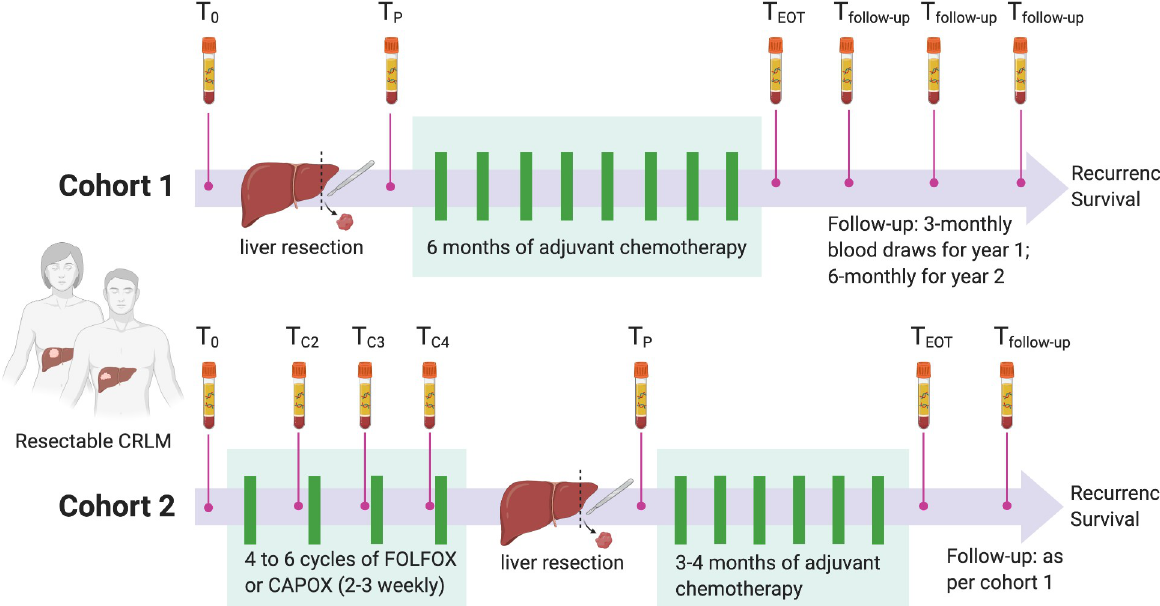
Fig 1. Study design. Study schema showing blood collection time points in Cohort 1 (upfront liver resection) and Cohort 2 (neoadjuvant chemotherapy). The primary objective of the study was to assess the prognostic impact of postoperative ctDNA (T P ) on recurrence-free survival in the total population. T 0 = baseline, T C2 = pre-cycle 2, T C3 = pre-cycle 3, T C4 = pre-cycle 4, T P = 4 to 10 weeks postoperative, T EOT = end of treatment, T follow-up = follow-up. CRLM AU : AbbreviationlistshavebeencompiledforthoseusedinFigs 1 (cid:0) 6 : Pleaseverifythatallentriesarecorrect : , colorectal cancer liver metastasis; ctDNA, circulating tumor DNA.